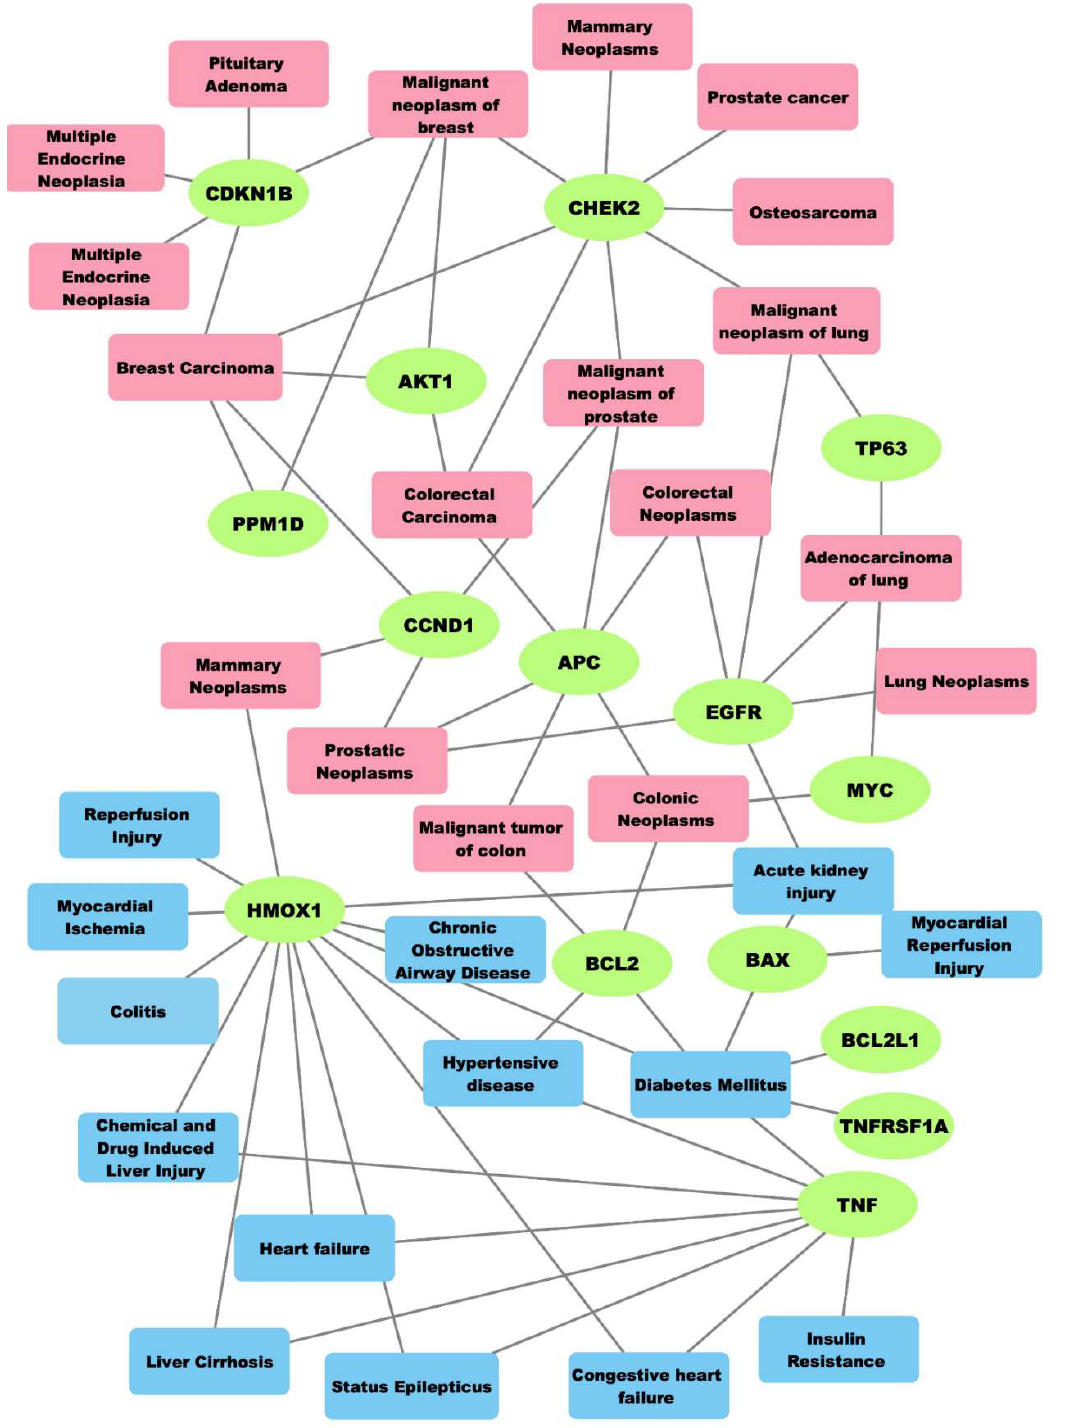
Figure 2. Integrated network depicting the top-ranking pairwise relationships (indicated by edges or lines) between genes-neoplasms, and genes and non-neoplastic diseases, derived from DisGeNET; green: genes, magenta: neoplasms, blue: non-neoplastic diseases often appearing as comorbitidies in various types of cancer therapies, like radiation therapies.